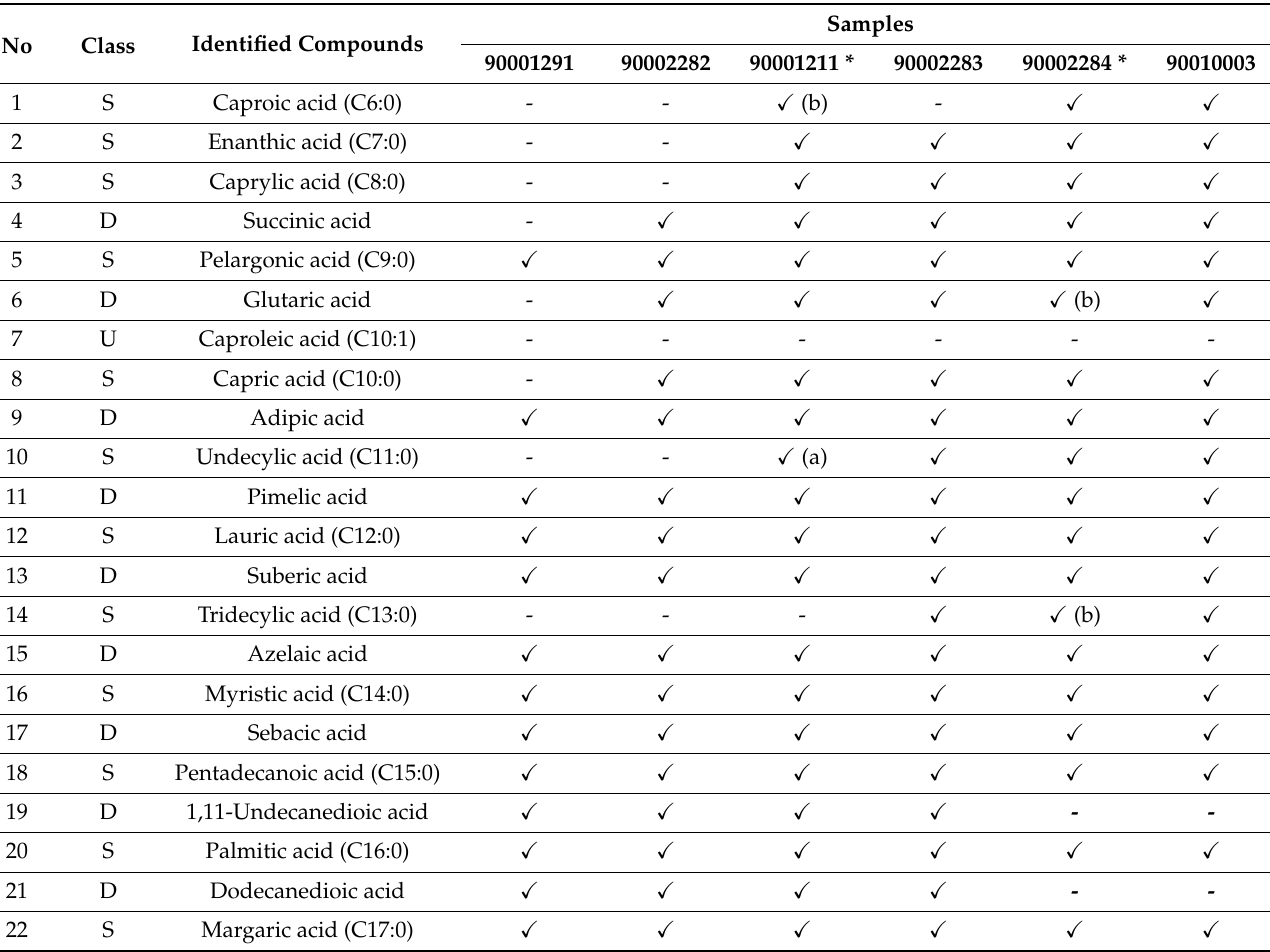
Table 2. List of compounds identified by GC-MS analysis of embalming substances from gazelle mummies (D: dicarboxylic acids; S: Saturated fatty acids; U: Unsaturated fatty acids; R: Resinic acids; DH: Dihydroxycarboxylic acids; St: